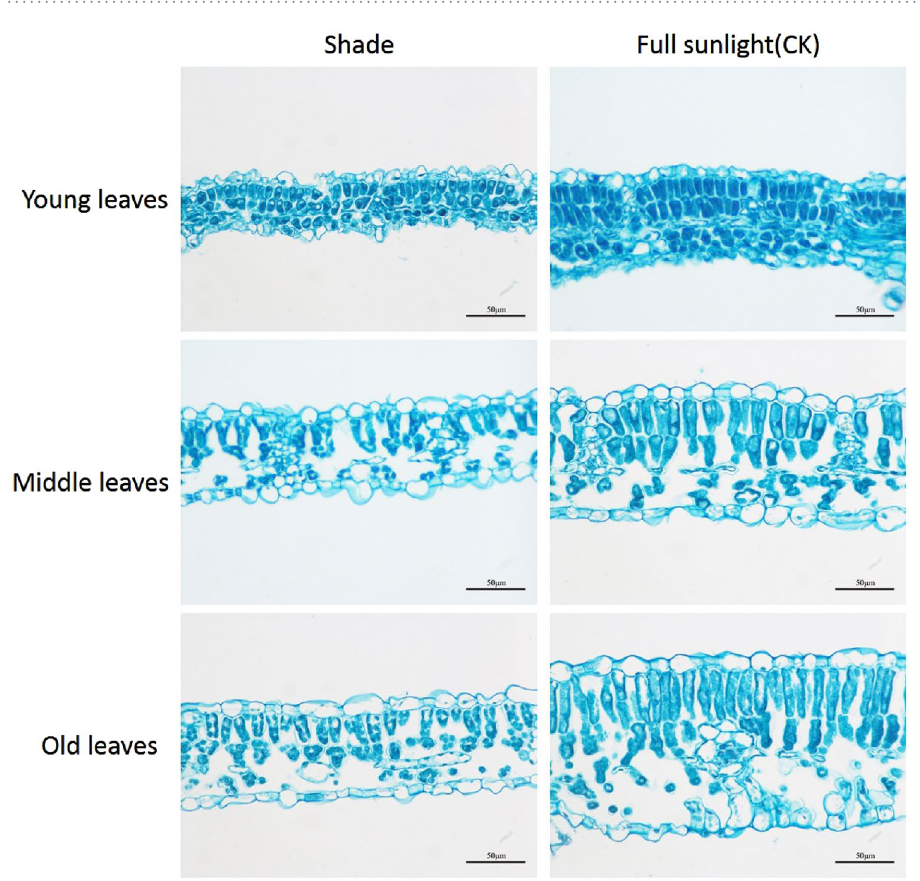
Figure 4. Transverse sections and microscope views of leaves of 30 days soybean plants grown in shade and full sunlight (CK). The transverse sections reveal a region between the midvein and the leaf margin. Bars, 50 µ